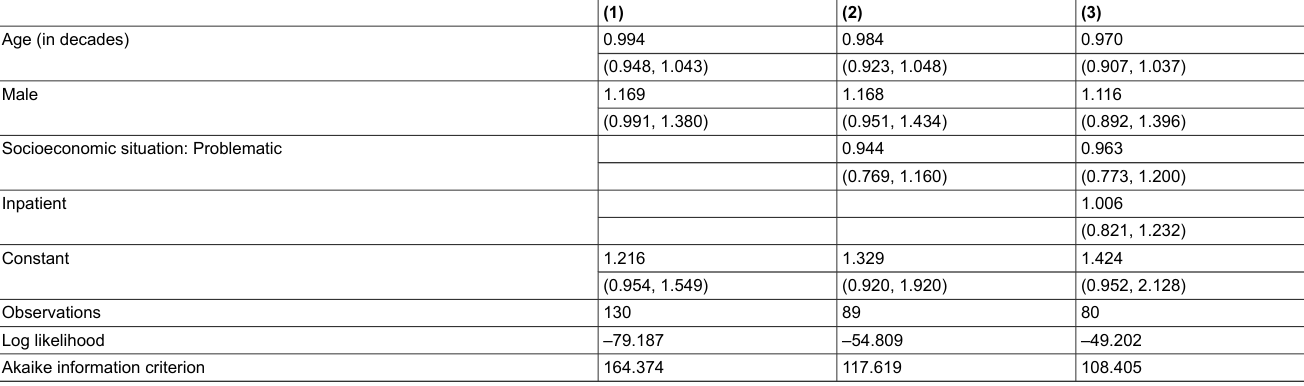
Table 6: Logistic regressions on the response : “Suicide method = Hanging”.